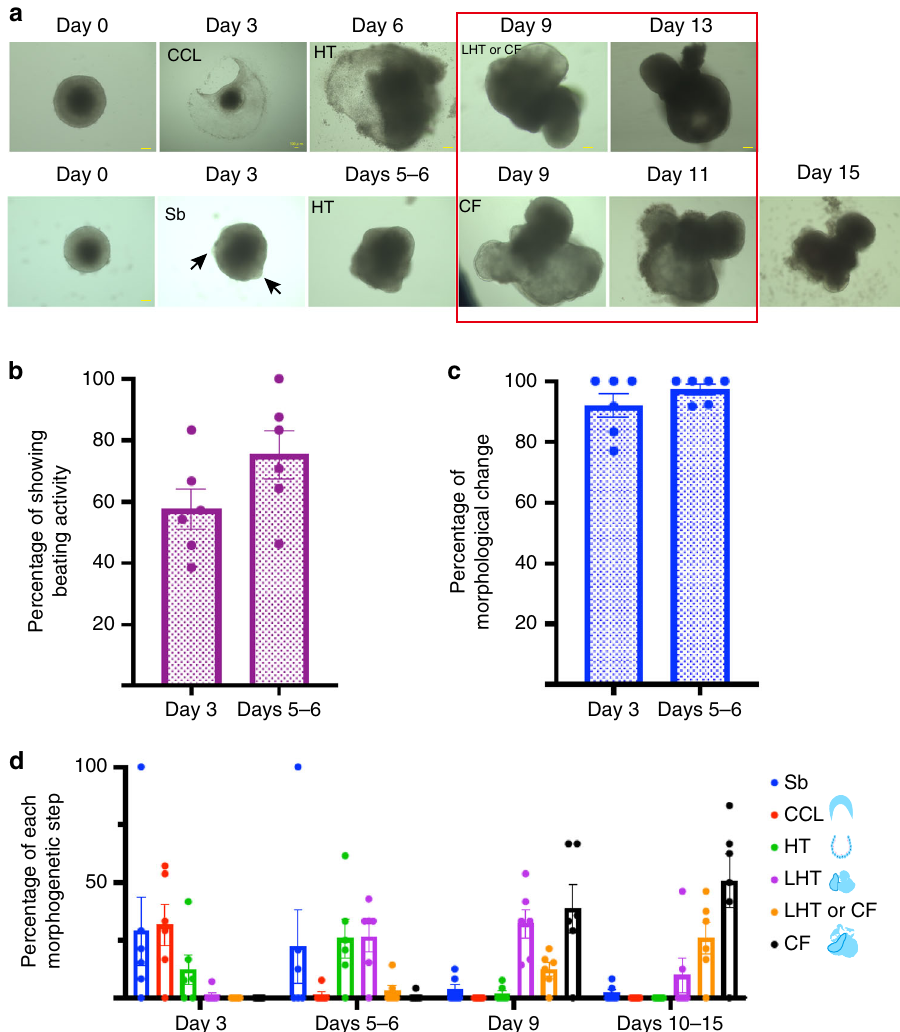
Fig. 3 Different morphological stages during the in vitro cardiogenesis. a Heart organoid (HO) tracking over a time course (over n = 84, over six independent experiments). The cardiac-crescent-like structures (CCL, top) or sphere with buds (Sb; similar to a small heart tube with polarity, bottom) appeared within 3 days of culture. Arrows indicate buds in a Sb. These structures underwent continuous morphological changes into heart tubes (HT), looping heart tubes (LHT) and chambered hearts (scale bar: 100 µ m). The HOs were classi fi ed as being in the cardiac-crescent-like, Sb, heart tube, looping heart tube, or chamber-formation (CF) stage. b Half of the cultured HOs showed spontaneous beating movement within 3 days of culture (57.6%). The number of beating HOs increased at day 6 (75.4%; n = 84, six independent experiments). See also Supplementary Movie 4. c Morphological changes in the EBs appeared within 3 days of culture. At day 3, EBs with a spherical shape prior to culture had transformed into cardiac-crescent-like structures or Sbs (92.0%). Most EBs showed morphological changes until day 6 (97.3%). d Frequency of HOs with certain morphological characteristics according to the culture period. The majority of the HOs were classi fi ed as being in the cardiac-crescent-like stage (red bar) at day 3 and transformed to the heart tube and looping heart tube stages (light green and purple, respectively, days 5 − 6), looping heart tube and chamber-formation stages (purple and black, respectively, day 9) and fi nally to the chamber-formation stage (black) at days 10 − 15. Data are presented as mean values ± SEM in ( b – d